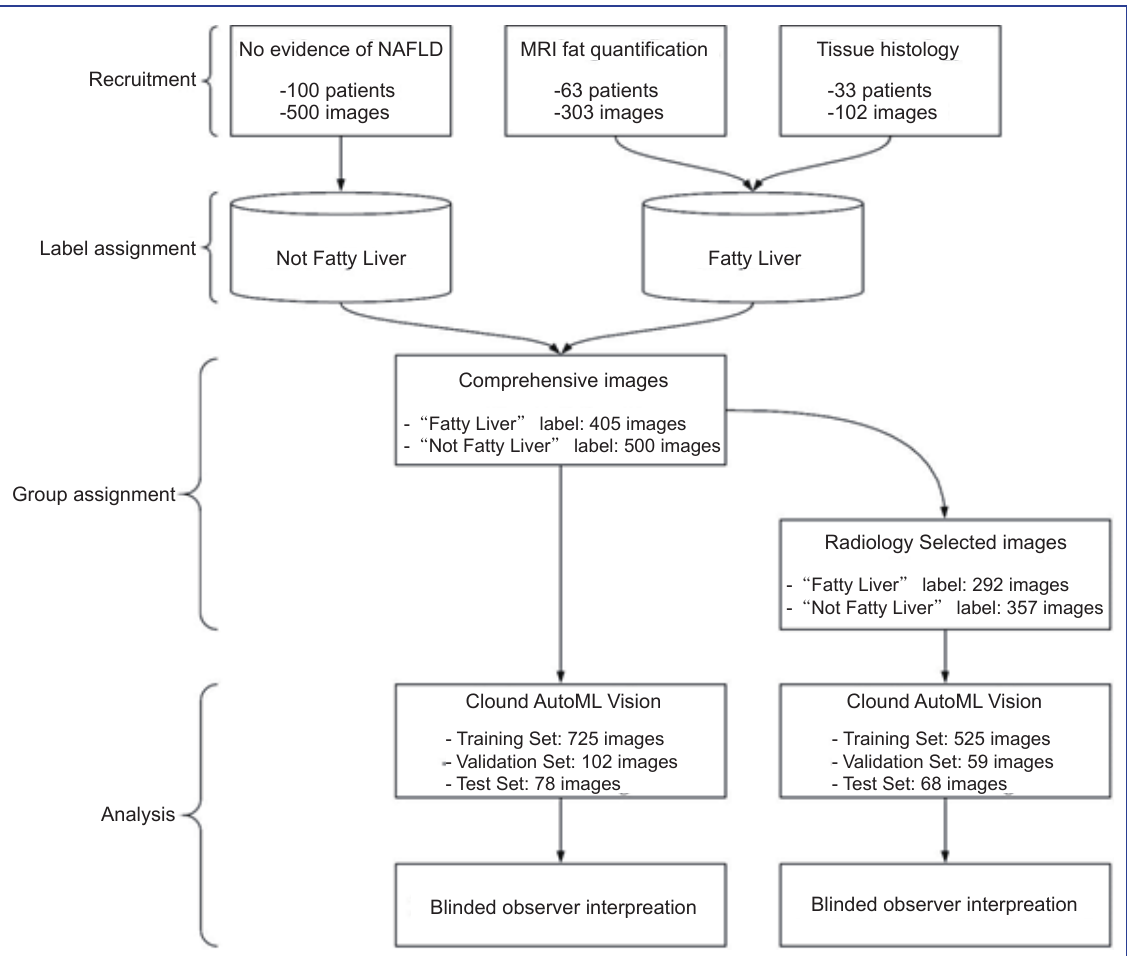
Figure 2 Workflow of data used for model creation and